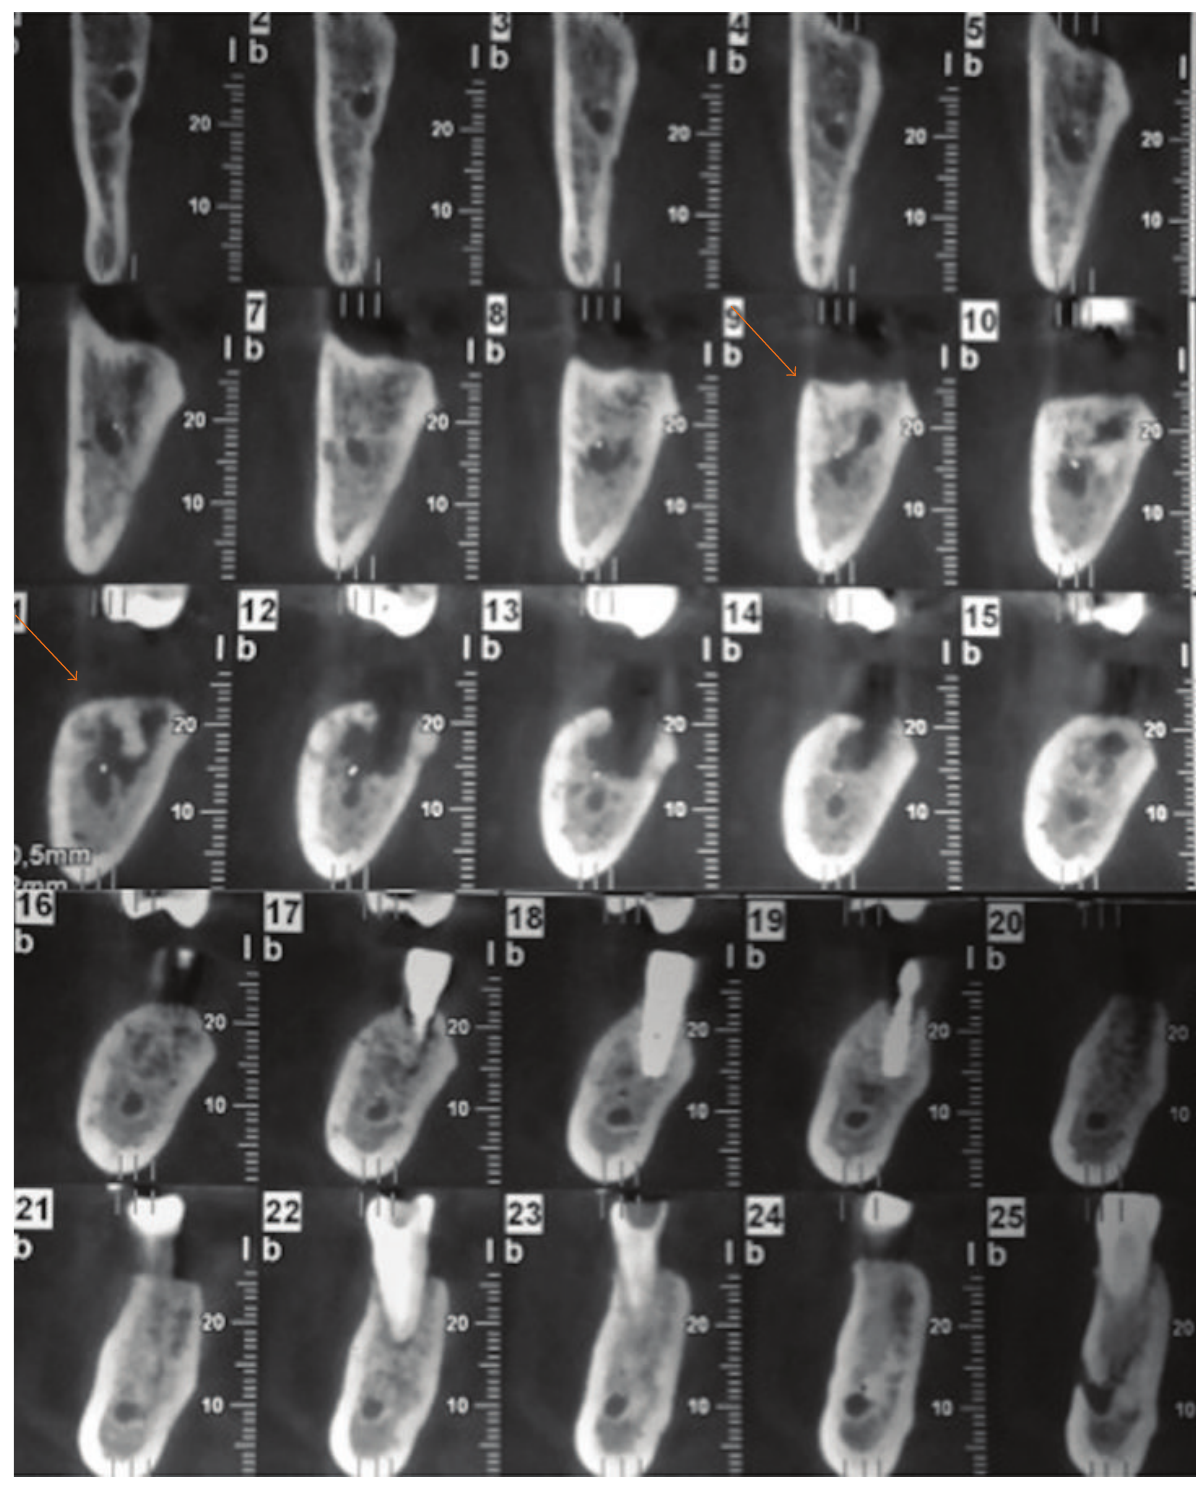
Figure 2: CT Dentascan scan performed on July, 2011, showing